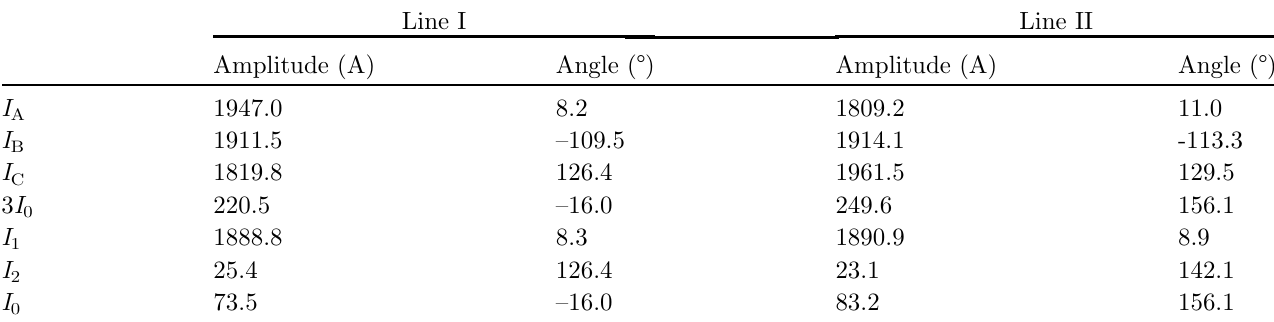
Table 3. The amplitude and phase angle of the sequence component of the line current on the YD side (calculation results).